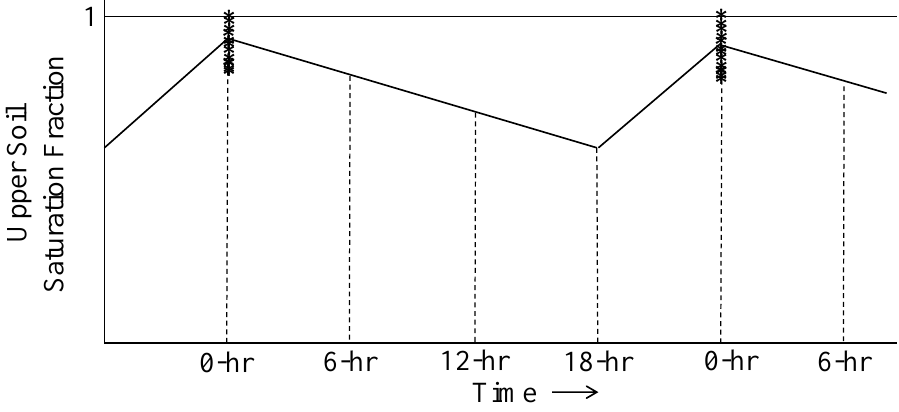
Figure 4. Illustration of each Monte Carlo simulation (*) result, the averaging that occurs at each assimilation time-step, reflecting that inundation information is provided daily at